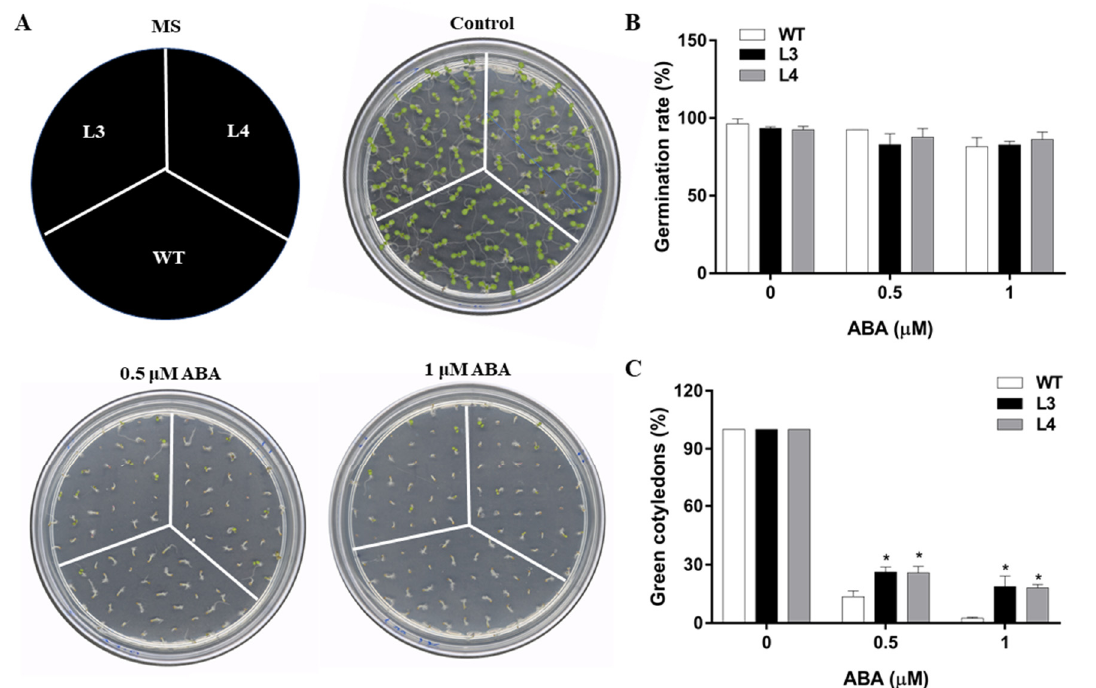
Figure 3. Germination and green cotyledon analysis of Arabidopsis under ABA treatment. ( A , B ) Germination rates. ( C ) Cotyledon greening rates. Error bars represent ± SD ( n = 3). Asterisks denote significant differences (as compared with the control group): * p < 0.05.